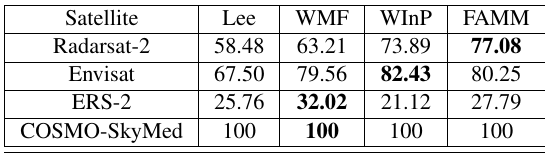
Table 3: The percentage of the number of pixels with DEM error lesser than 50 meters with respect to the total number of DEM error pixels for the four different